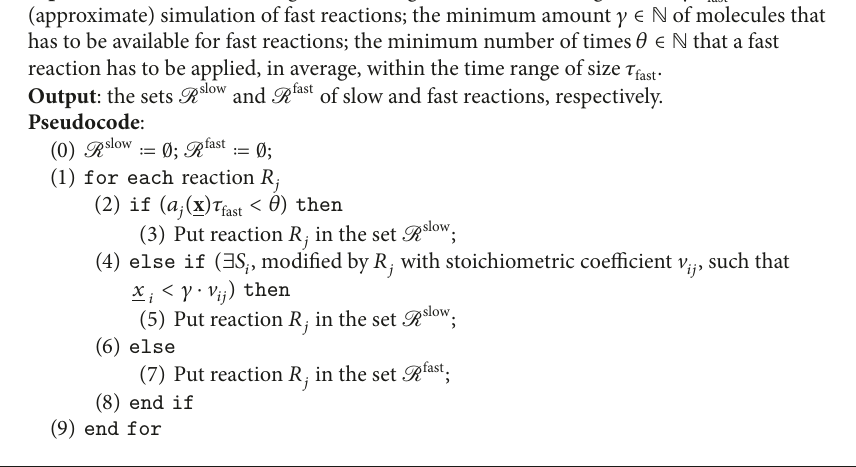
Algorithm 5: The dynamic reaction partitioning of HRSSA (please refer to [21] for